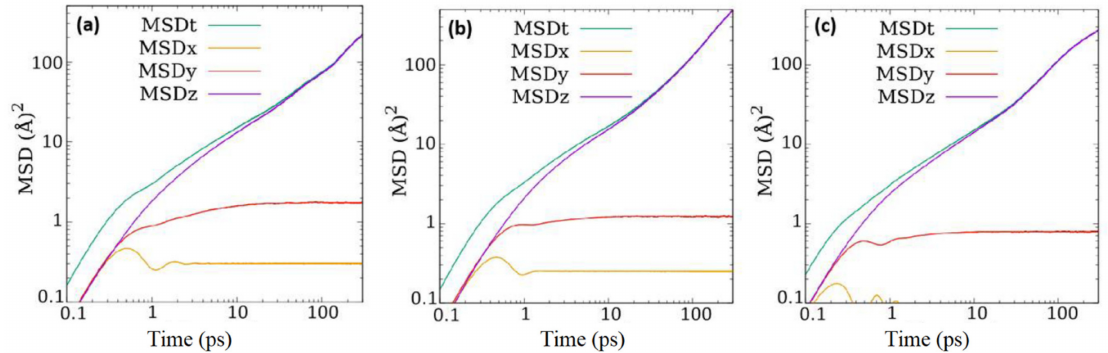
Figure 5. Components of mean squared displacement (MSD) along different directions and the overall MSD (MSDt) for ( a ) CO 2 , ( b ) CO 2 without electrostatic interactions, and ( c ) ethane in ZSM-22 at a loading of 52 molecules in the simulation